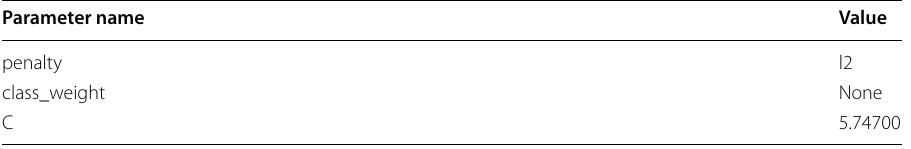
Table 73 Modes of LR tuned hyperparameter values for experiments with the information theft dataset